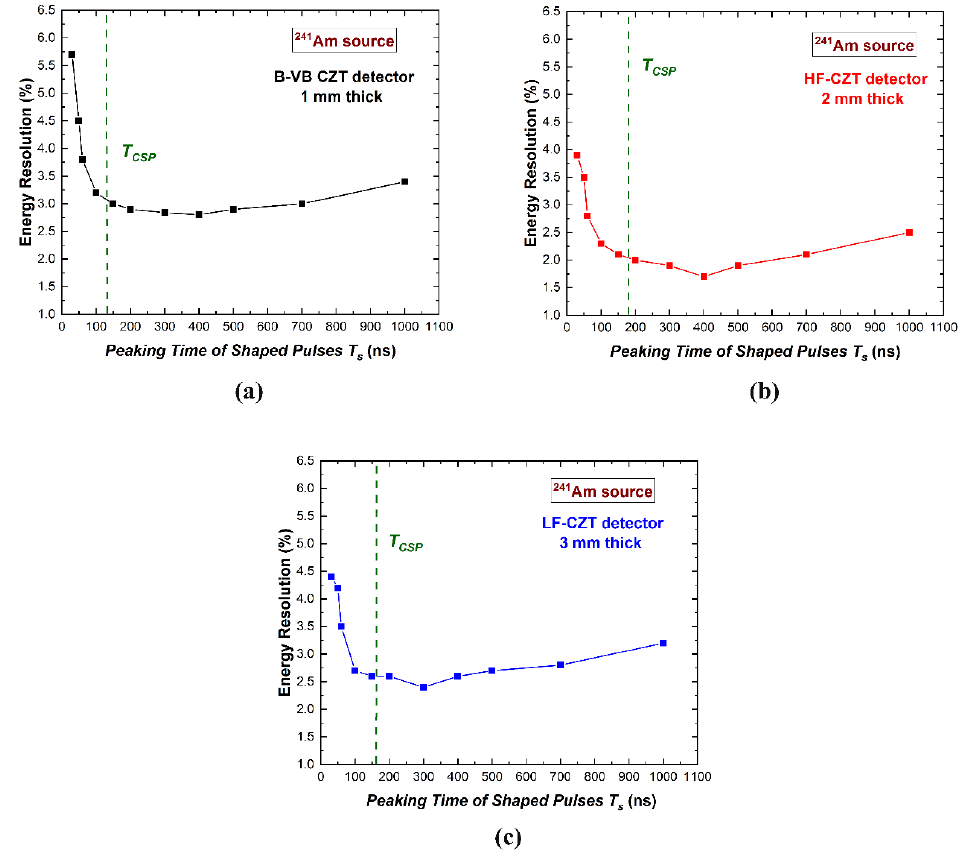
Figure 5. Measurement of the energy resolution (FWHM) at 59.5 keV vs. the peaking time of the shaped pulses. The results for the ( a ) B-VB CZT pixel detector, ( b ) HF-CZT pixel detector, and ( c ) LF-CZT pixel detector. The green dashed vertical lines represent the mean value of the peaking times T CSP of the CSP output pulses.